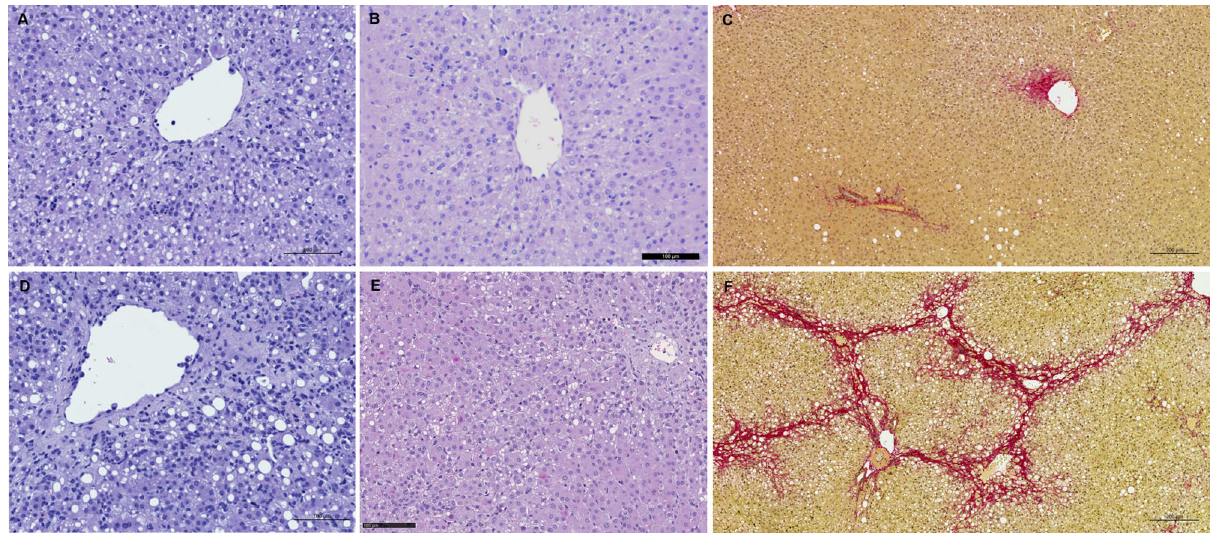
Figure 3. Liver histology. Representative images of Charles River and Envigo animals with NAS similar to group medians at week 16 and 24/25. ( A ) Charles River animal with NAS = 6 at week 16. ( B ) Envigo animal with NAS = 3 at week 16. ( C ) Charles River animal with NAS = 7 at week 24/25. ( D ) Envigo animal with NAS = 5 at week 24/25. Representative images of mild F1 ( E ) and bridging (advanced) F3 ( F ) fibrosis. Scale bar is 100 μm